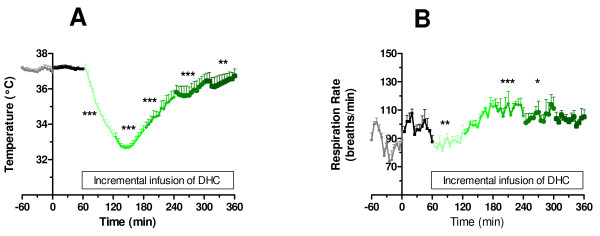
Blood temperature (A) and respiration rate (B) in healthy conscious rats. Following baseline characterization animals were infused at t = 0 with vehicle control for 1 hour followed by incremental doses of DHC of 1.0; 2.0; 2.2; 2.4; and 3.0 mg/kg/hr for 1 hour at each condition. Statistics: Each of the doses of DHC were compared to the vehicle control situation by a 1-way ANOVA followed by Dunnett's multiple comparison test ***p > 0.001, **p < 0.01, *p < 0.05. Values are expressed as average ± SE, with n = 6, see Methods for further details.